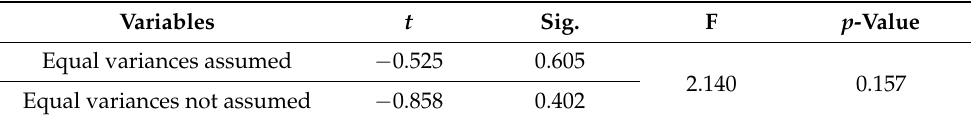
Table 3. CPNs websites’ organic traffic Levene’s t -test before and after the crisis.